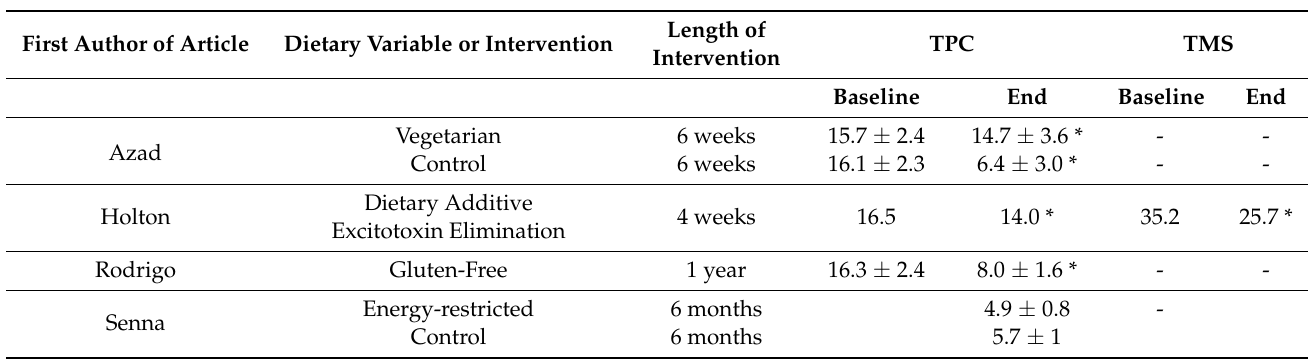
Table 3. Effects of diets on pain symptoms measured by Tender Point Count (TPC) and Total Myalgic Score (TMS).